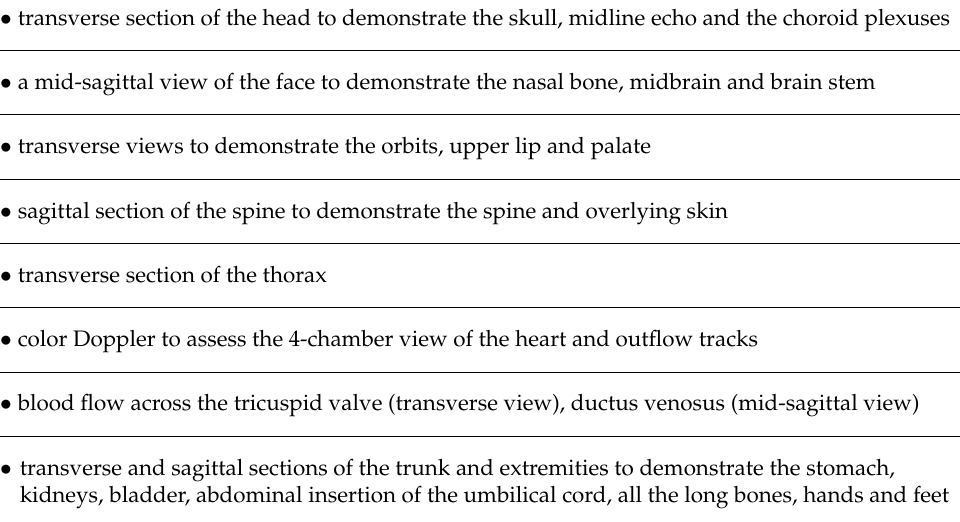
Table 1. First trimester fetal anatomy assessment—Routine views